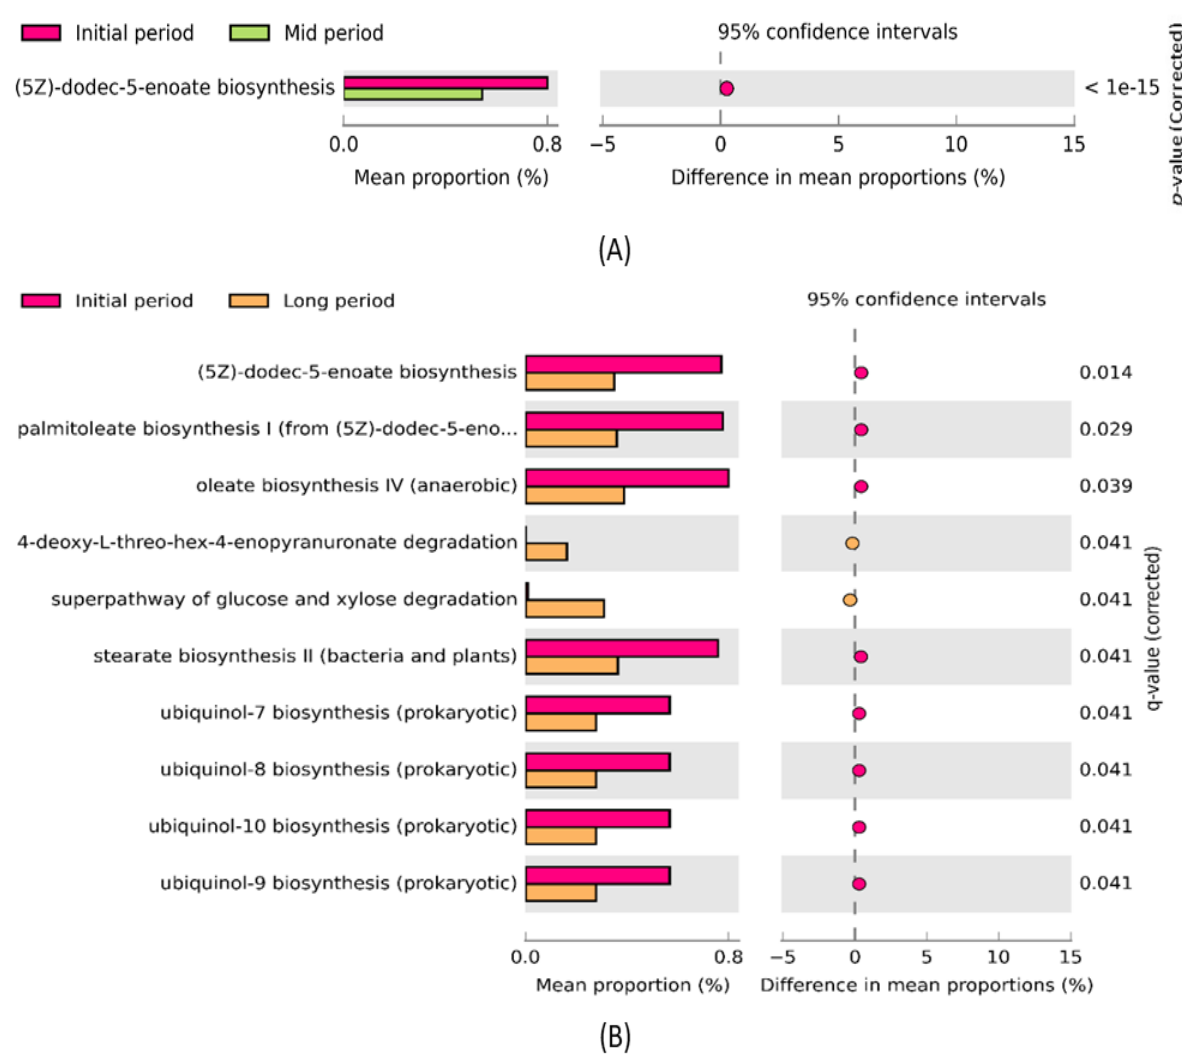
Figure 7. Post hoc plot of significantly enriched predicted metabolic functions among ( A ) initial- and mid-period samples showing significant enrichment of one metabolic function; ( B ) initial- and long-period samples showing significant en- richment of 10 metabolic functions. The figures show the abundance of the enriched predicted metabolic functions in the left-side panel, the mean proportion (%) of the enriched predicted metabolic functions in the middle, and the significant difference ( p < 0.05) in the right-side panel.